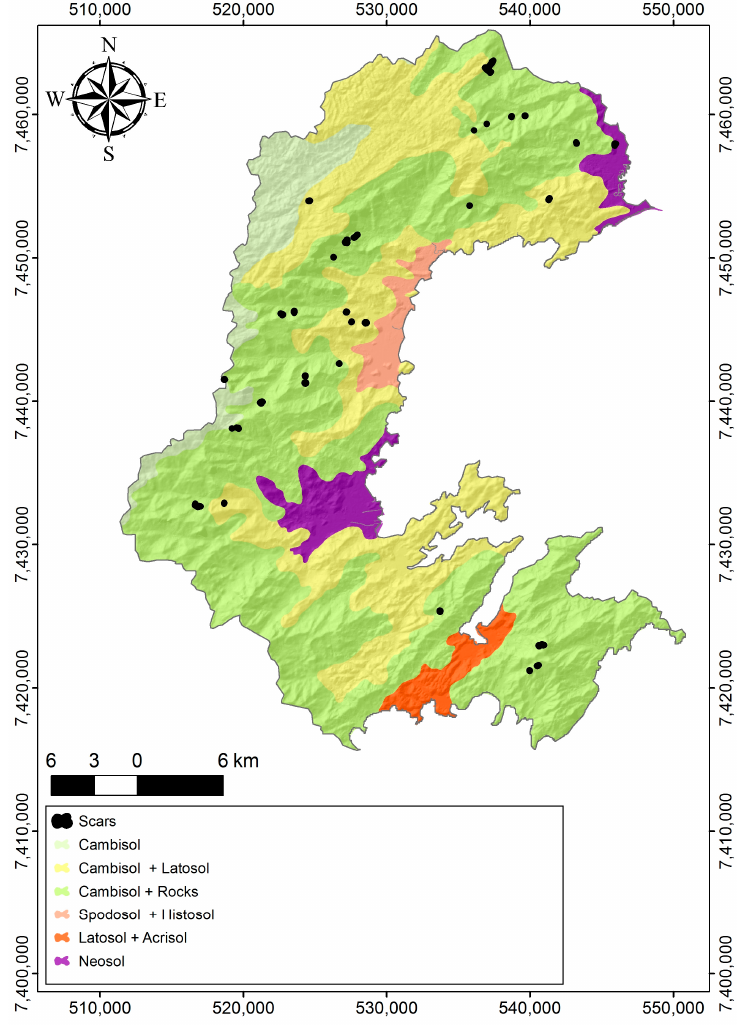
Figure 3. Soil map of the Paraty municipality.